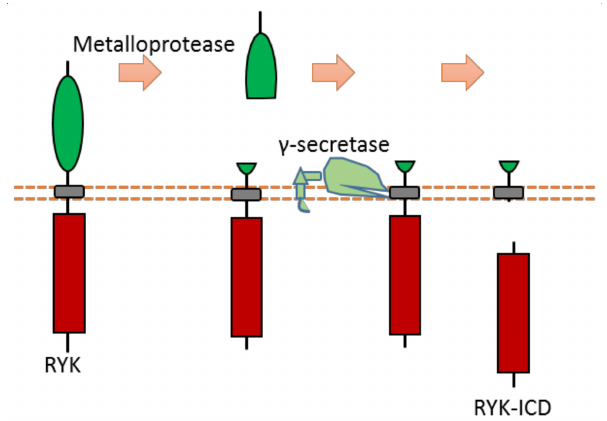
Figure 11. Schematic illustration of proteolytic cleavage in RYK.